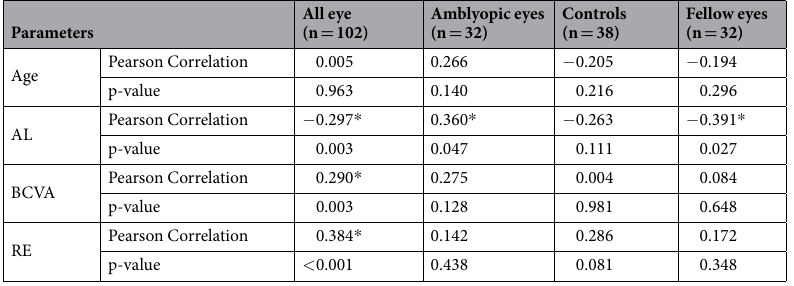
Table 3. Correlation between choroidal vascularity and clinical parameters. VA: visual acuity; BCVA: best- corrected visual acuity; RE: refractive error; AL: axial length. * Correlation is significant at the 0.05 level (2-tailed).